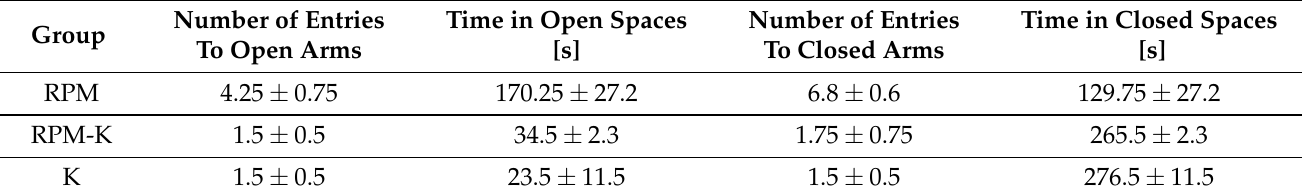
Table 5. Results from the elevated maze experiment (mean of ±